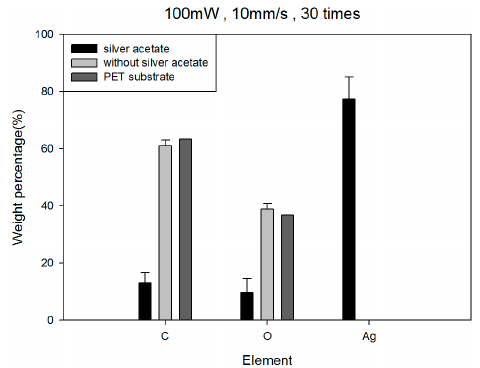
Figure 5. Scanning electron microscope (SEM) image of a silver line fabricated using a 16 mM process solution and 30 laser scans.